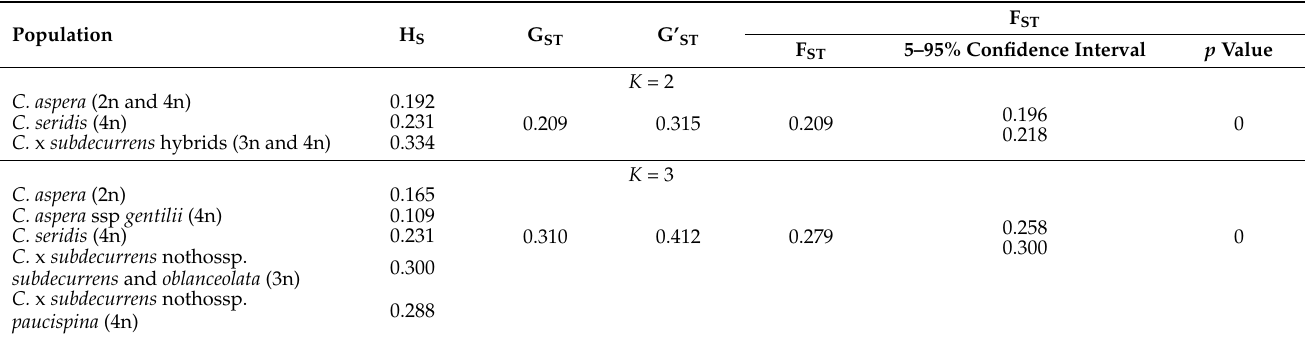
Table 1. Measures of population diversity and differentiation in Centaurea aspera and C. seridis using a large SNP set. STRUCTURE analysis was used for establishing genetic populations.